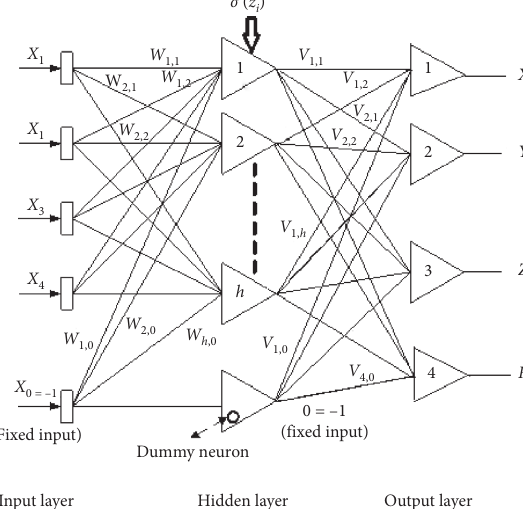
Figure 1: ANN architecture proposed to simulate conformable fractional helium burning